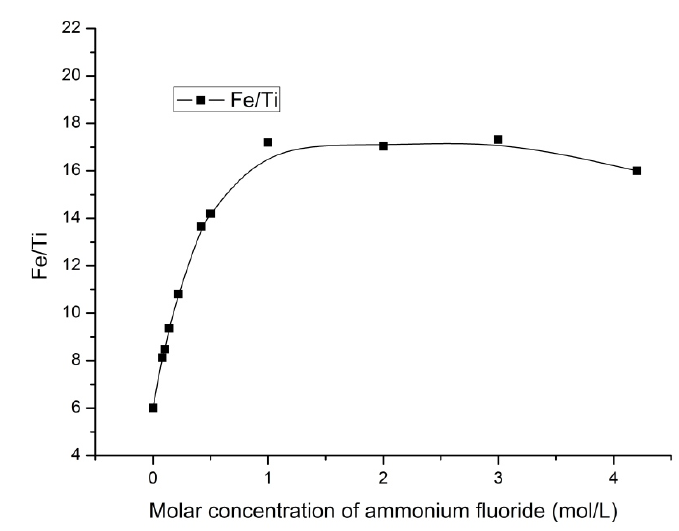
Figure 8. The Fe/Ti ratio in solid samples vs. concentration of ammonium fluoride.